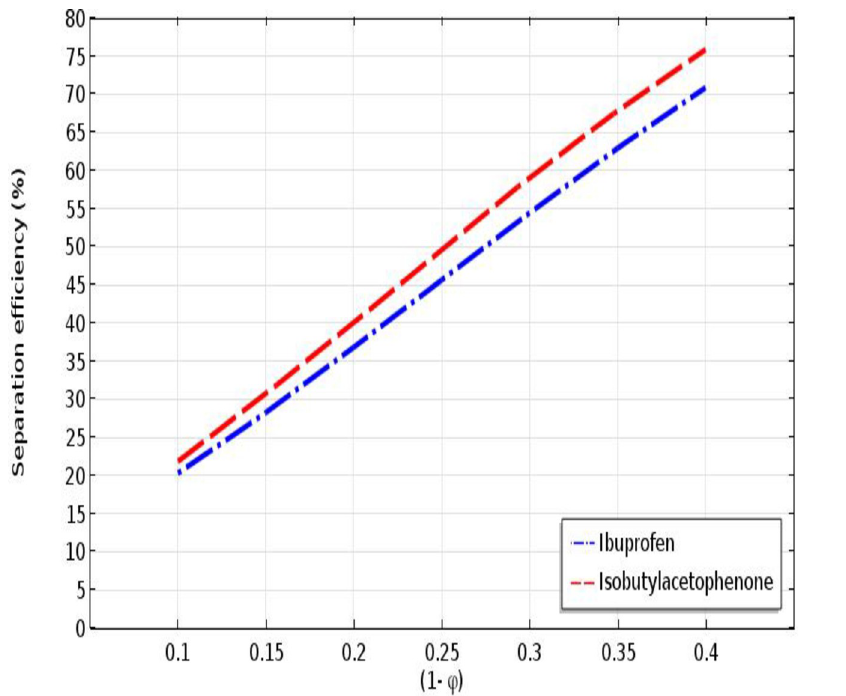
Fig 12. Effect of the packing density on the IP and 4-IBAP solutes molecular